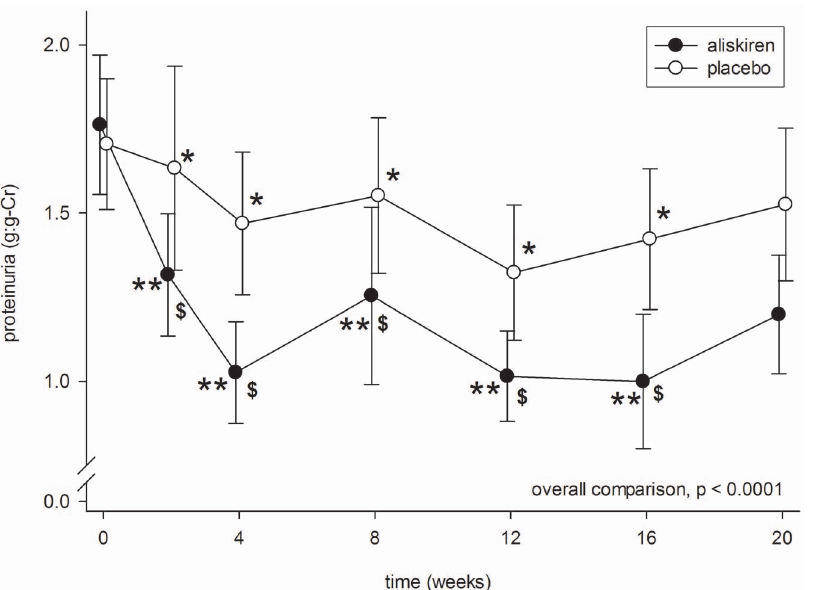
Figure 2. Serial change in proteinuria during the periods of aliskiren (closed circles) and placebo (open circles) treatment. Error bars denote standard error of mean. Post-hoc comparisons were performed by paired Student’s t test: *p , 0.05 and **p , 0.0001 as compared to baseline level; $ p , 0.01 as compared to the period of placebo treatment. All P values were computed with Bonferroni adjustment for multiple comparisons.